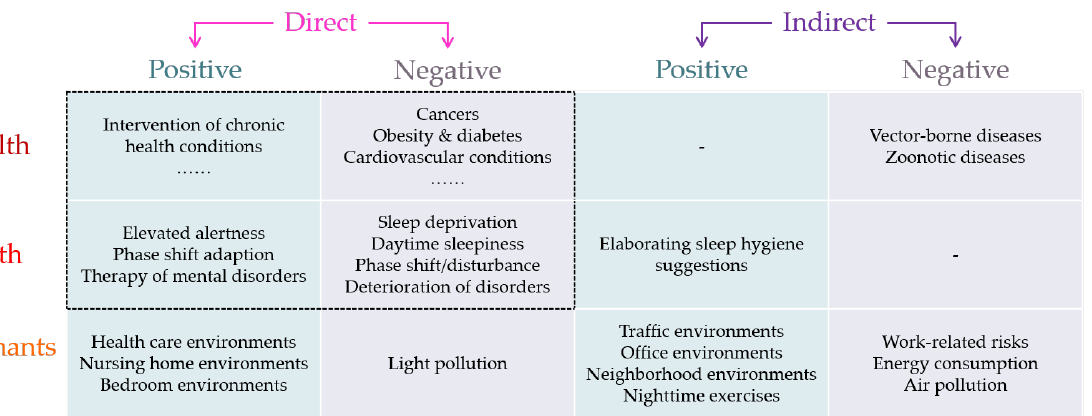
Figure 6. The multi-component framework to link ALAN with human health.